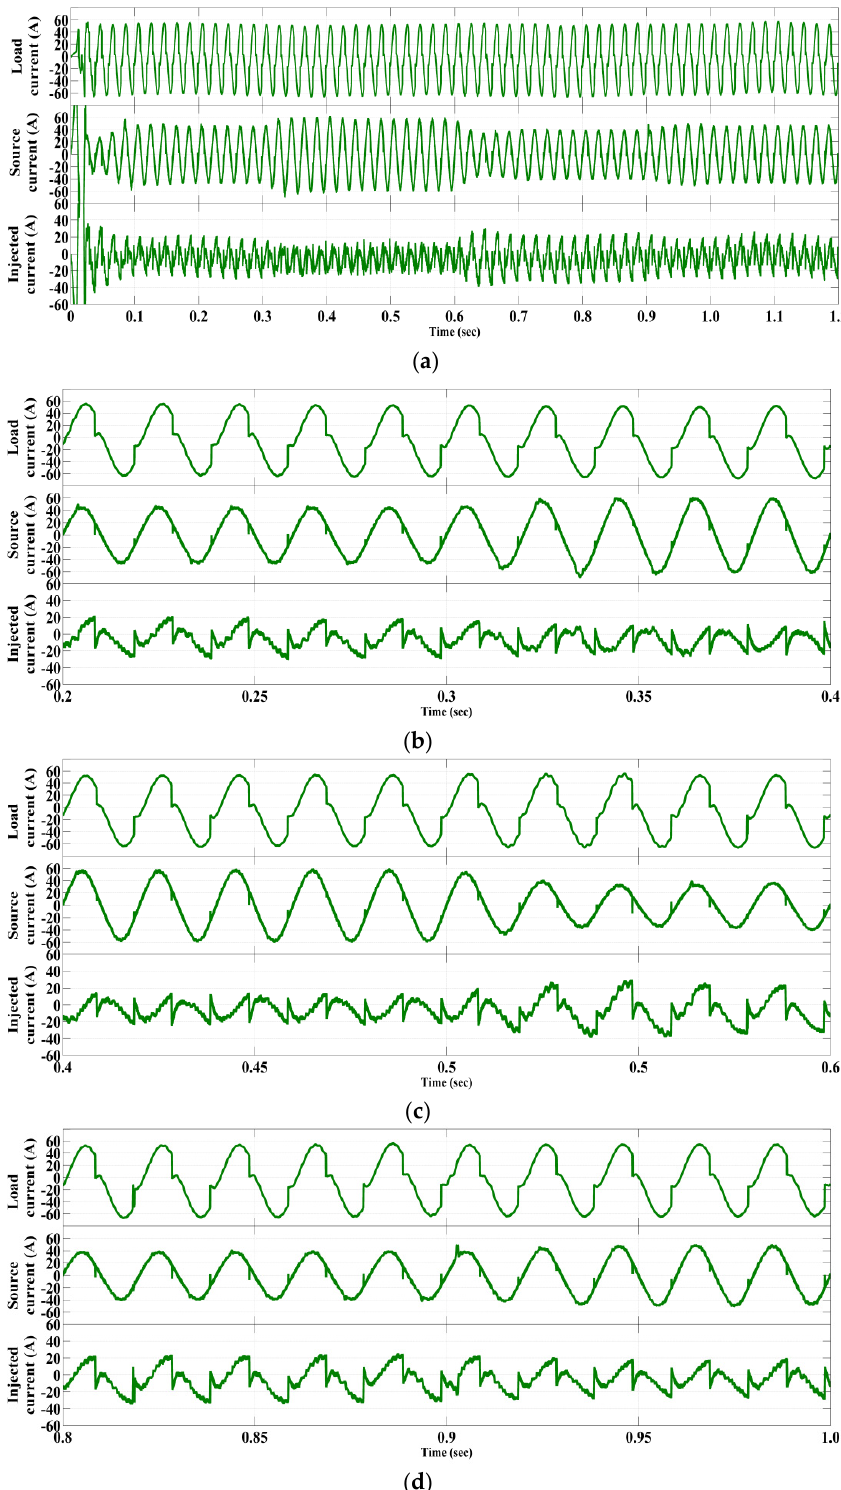
Figure 4. Simulation results with composite load (linear and non ‐ linear): source voltage, load voltage and series injected voltage (top to bottom) at ( a ) 0–1.2 s, ( b ) 0.2–0.4 s, ( c ) 0.5–0.7 s and ( d ) 0.8–1.0 s.